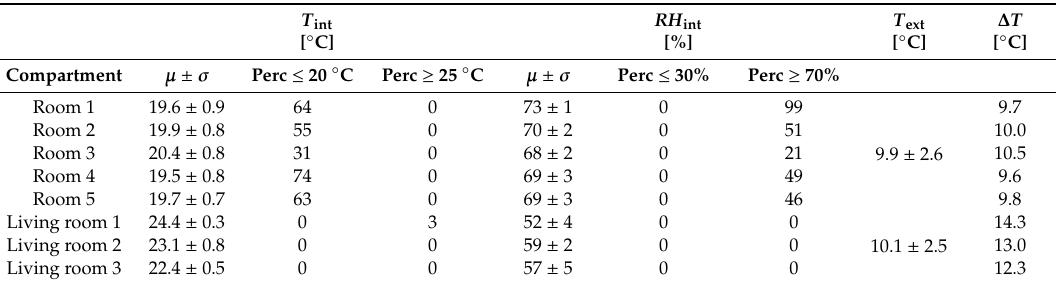
Table 10. Statistical analysis of the hygrothermal parameters recorded in compartments of ECC 2: 1 st trial (4 to 8 January).